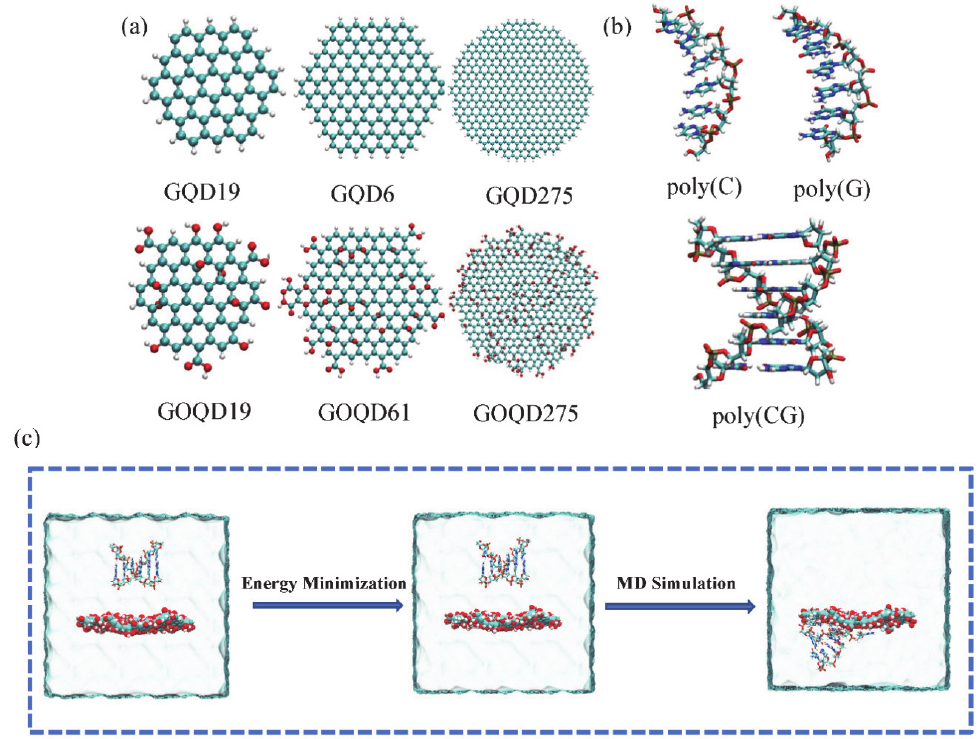
Figure 1. ( a ) Graphene quantum dots with different sizes and oxidation: GQD19, GQD61, GQD275, GOQD19, GOQD61, and GOQD275, respectively; ( b ) The initial structure of ssDNA and dsDNA used in this study. ( c ) Schematic diagram of the system from its initial conformation to conformations after energy minimization and MD simulation. Water is shown transparently.